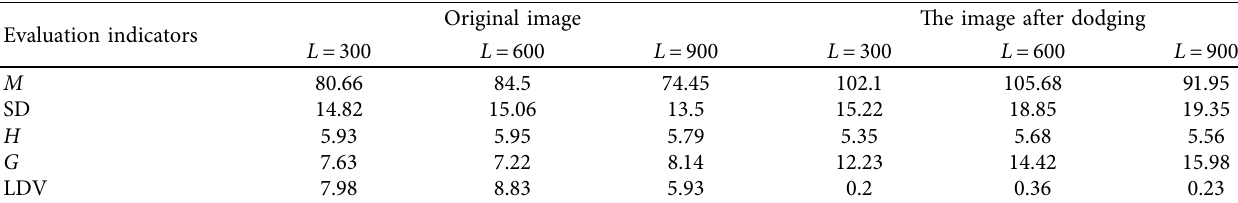
Figure 11: Comparison of before and after dodging results for images of different lengths: (a) original images of different lengths; (b) results of dodging of images of different lengths. Table 4: Evaluation parameters of before and after dodging for images of different